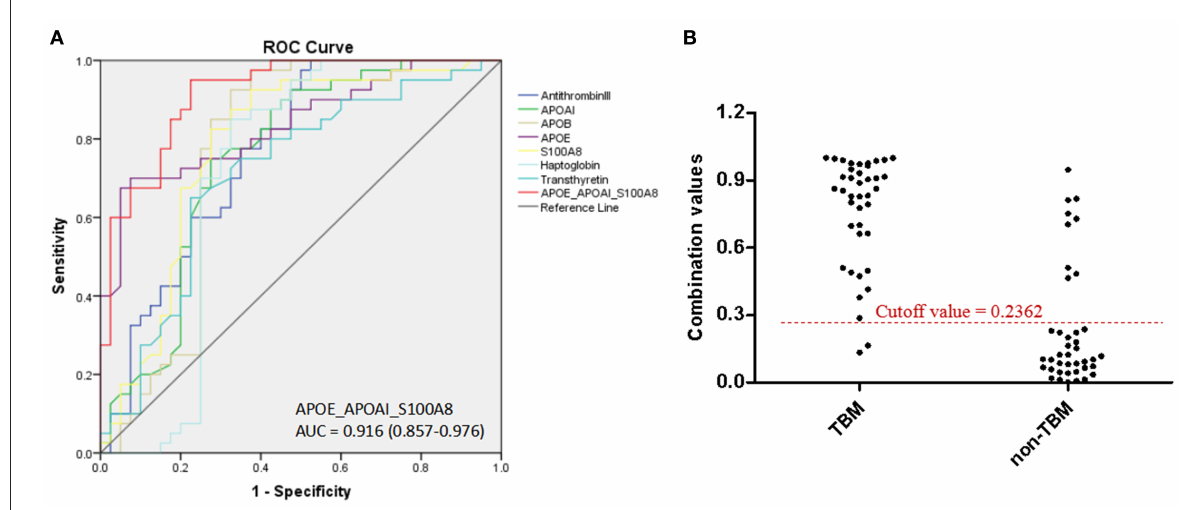
FIGURE5 The diagnostic value of CSF proteins and the panel (APOAI_APOE_S100A8) in distinguishing TBM from patients with non-TBM. (A) The receiver operating characteristic curve (ROC) depicts the sensitivity and specificity of the proteins and the panel in CSF in distinguishing TBM from patients with non-TBM. (B) Scatter plot showing the ability of the diagnostic panel (APOAI_APOE_S100A8) in distinguishing TBM from patients with non-TBM. TBM, tuberculous meningitis; CSF, cerebrospinal